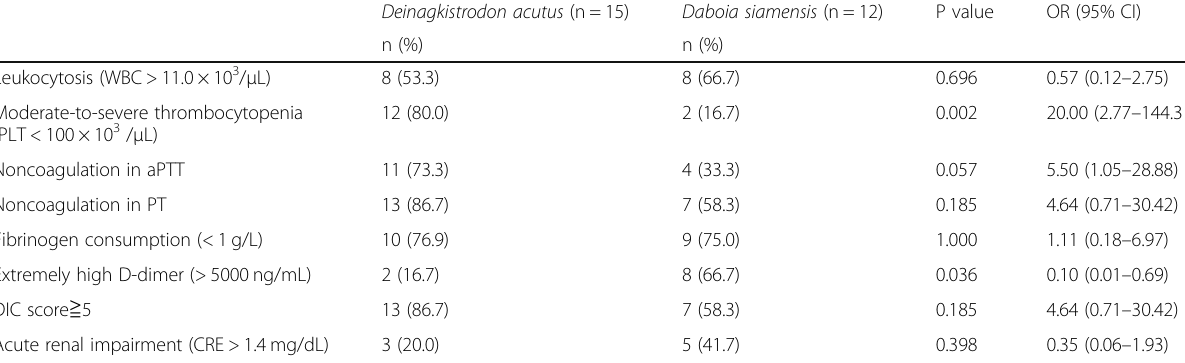
Table 2 Laboratory characteristics of patients with Deinagkistrodon acutus and Daboia siamensis envenomation